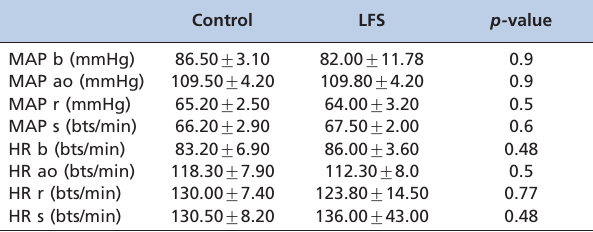
MAP: mean arterial pressure; HR: heart rate; b: beginning of the procedure; ao: during aortic clamping; r: 10 min after reperfusion; s: before sacrifice.